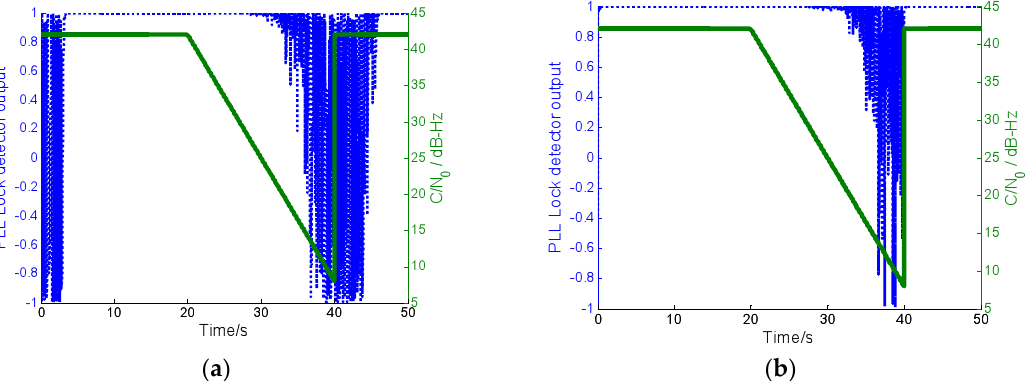
Figure 12. ( a ) PLL lock detector output of the conventional ultra-tight integration. ( b ) PLL lock detector output of our proposed ultra-tight integration.